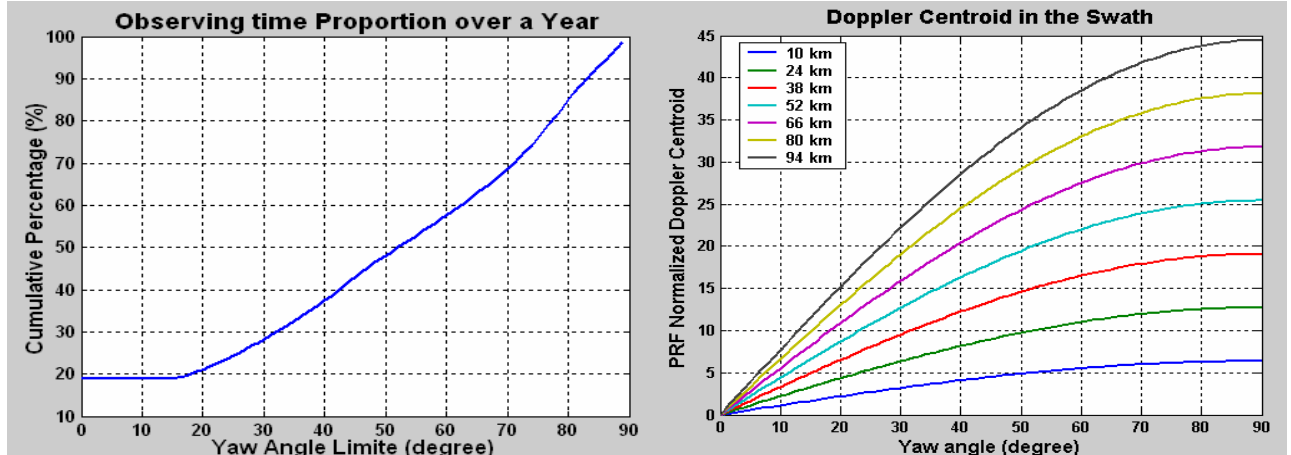
Figure 10. (a) Impact of the yaw steering onboard Jason-2 on the predicted observing time (b) Impact on the signal processing in terms of Doppler centroid.